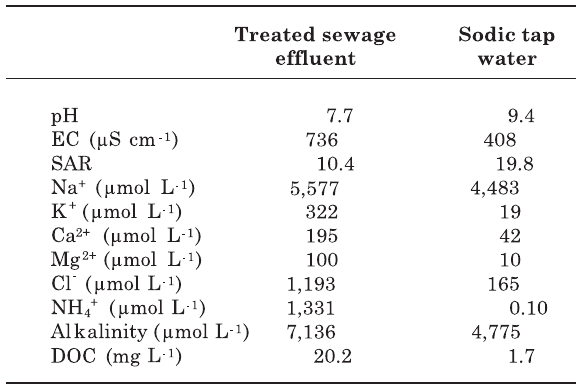
Table 1. Main chemical composition of irrigation waters (mean of 12 samples over two years)